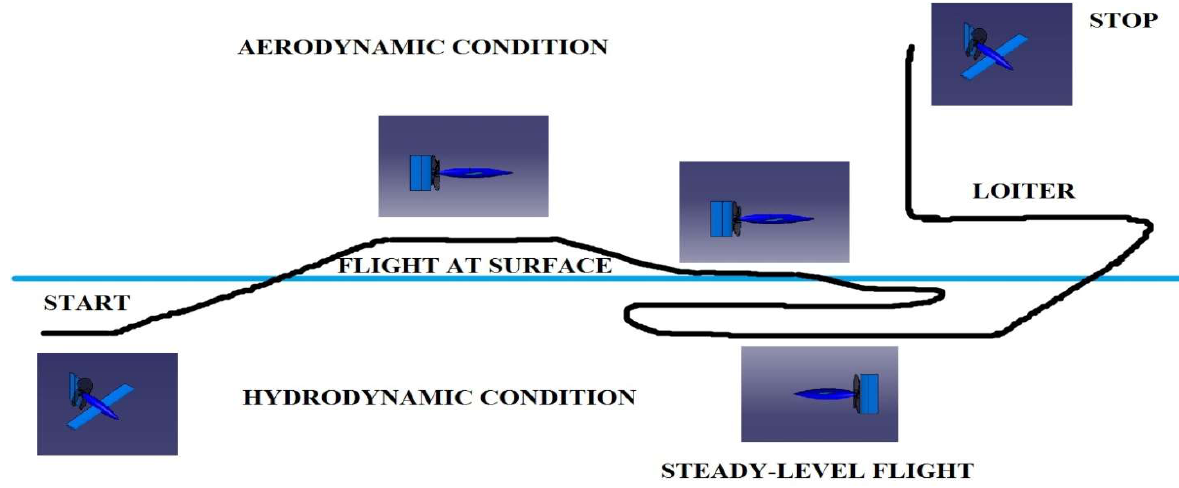
Figure 1. US’s Mission Profile of this proposed